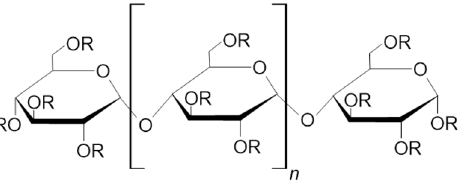
Figure 5. The general structure of sulfated maltooligosaccharides. R is SO 3 Na or H. The number n varies from 2 to 5 [58,59].